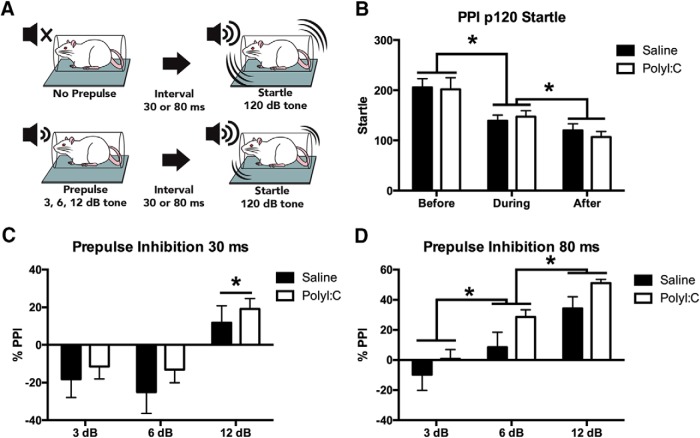
A, Schematic illustrating a startle response to a 120 dB tone (top panel) versus the typical reduction in startle reactivity when a prepulse of 3, 6, or 12 dB precedes the startling tone (bottom panel). Schematic has been published previously (Lins et al., 2018). B, Startle reactivity decreased over the course of the PPI testing protocol and polyI:C offspring had significantly higher reactivity at the “after” time point (*p < 0.05). C, There were no differences between groups in %PPI for the short (30 ms) prepulse-pulse interval but %PPI increased with increasing prepulse intensity where the 12 dB prepulse had higher PPI than 2 or 6 dB prepulses. D, There were no differences between groups in %PPI for the long (80 ms) prepulse-pulse interval but %PPI increased with increasing prepulse intensity (3 dB < 6 dB < 12 dB; *p < 0.05).